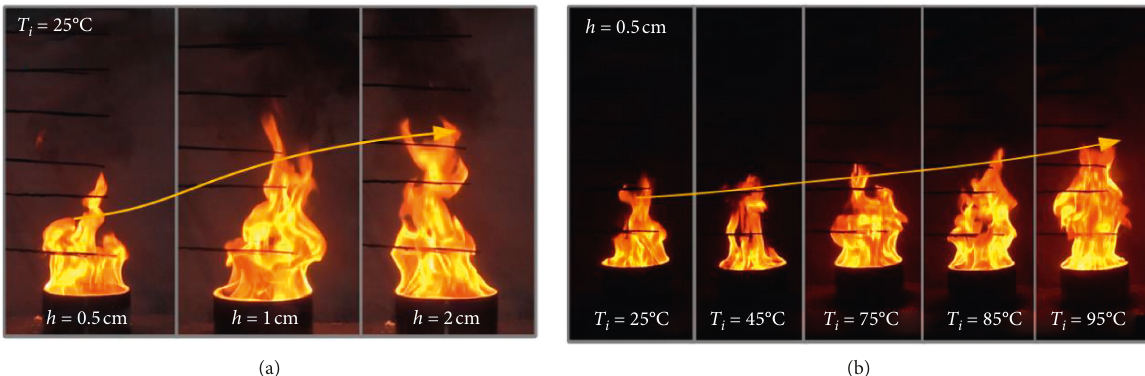
Figure 2: Typical flame images in steady stage under different experimental conditions. (a) Different fuel thickness conditions. (b) Different initial temperature